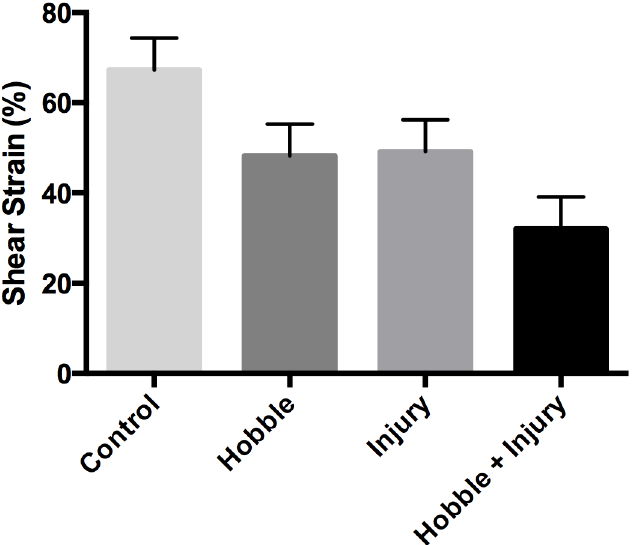
Fig 7. Perimuscular fascia shear strain measurements. Both injury and movement restriction (hobble) led to a significant reduction in thoracolumbar fascia shear strain (ANOVA main effects of injury p = .027, and hobble p = .021). There was no significant interaction between the effects of injury and